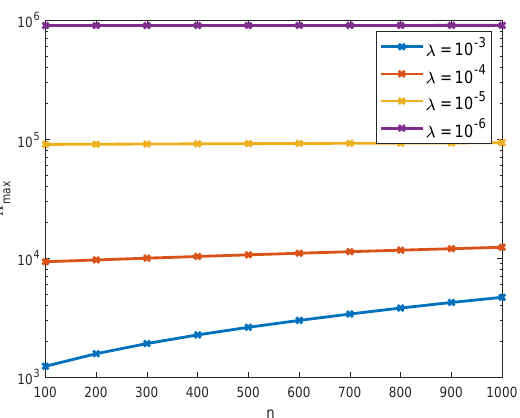
Figure 5. Fastest eigenvalue Λ max as λ decreases for different n x and constant N = 2. For the data, see Table A2.